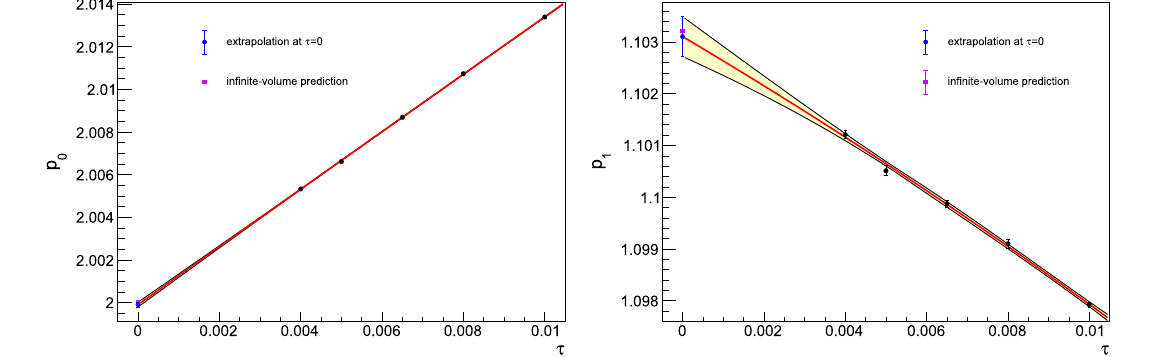
polynomial in τ . The extrapolated values are p 0 = 1 . 9999 ( 1 ) and p 1 = 1 . 1031 ( 4 ) with reduced χ 2 respectively equal to 1 . 710 and 1 .